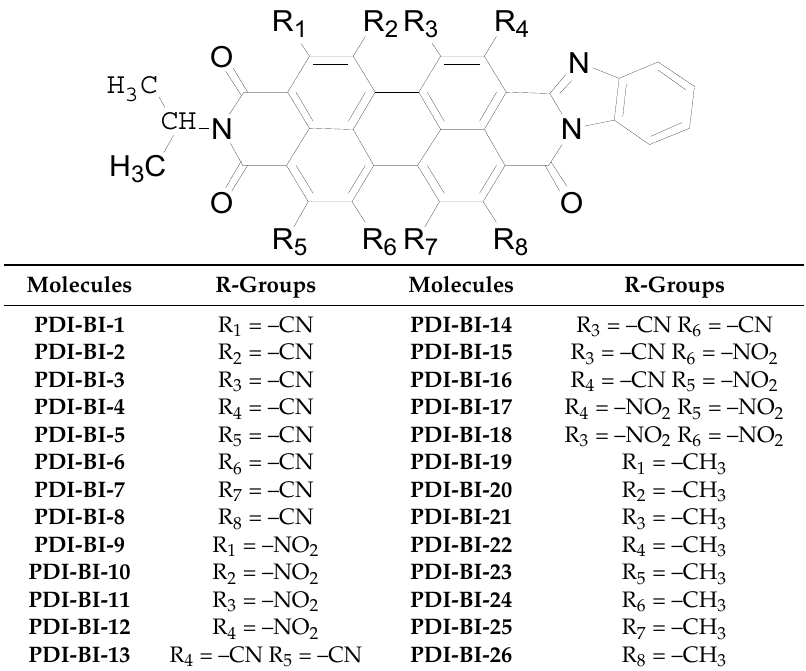
Table 1. Chemical structure of PDI-BI derivatives (Rn are –H except for mentioned in the